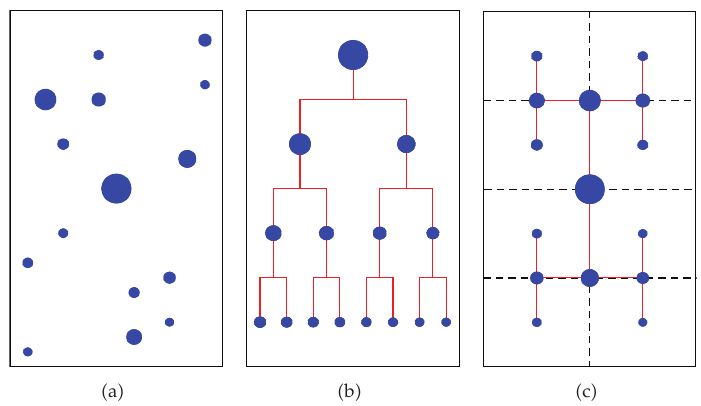
Figure 8: Hierarchical structure as a knowledge link between the apriori-ordered network and the random distribution of actual cities (cid:6) the first four classes (cid:7) . (cid:6) a (cid:7) Random distribution. (cid:6) b (cid:7) Hierarchy. (cid:6) c (cid:7) Ordered